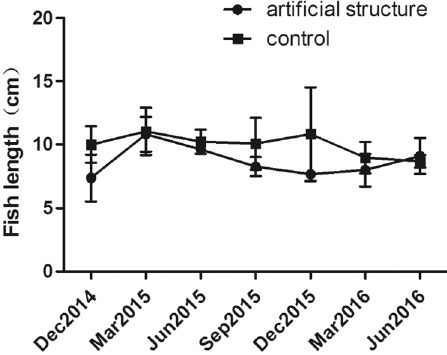
Fig. 4. Fish length recorded each sampling month at arti fi cial structures and control